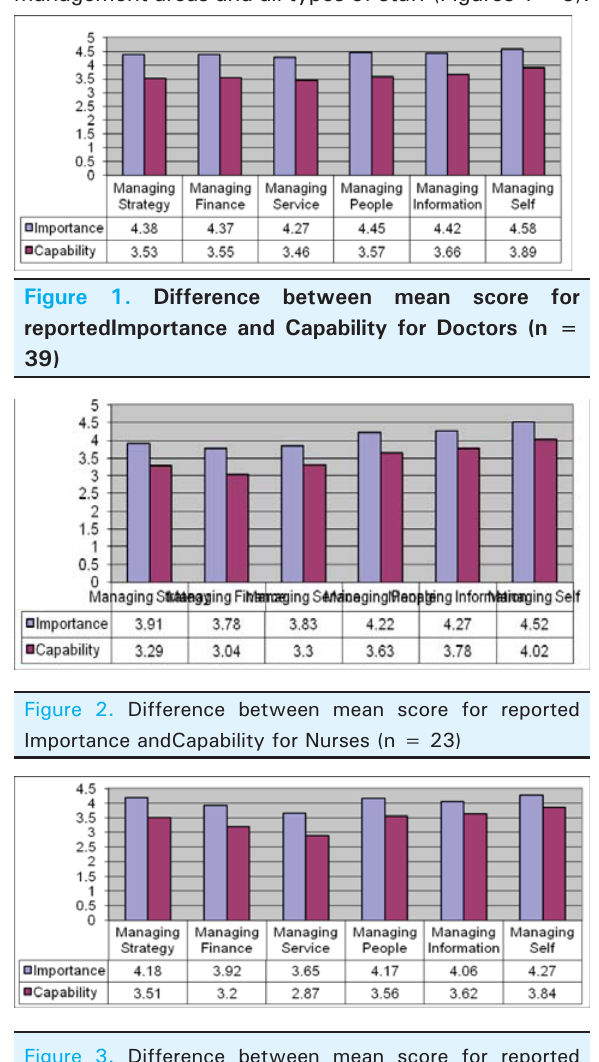
Figure 3. Difference between mean score for reported The time Importance and Capability for Administrators (n =